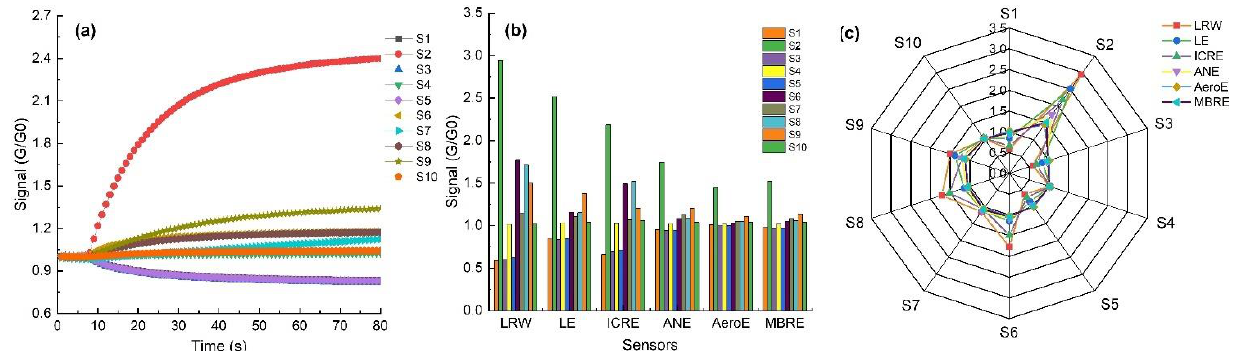
Figure 3. A typical response of EN sensor array during exposure to sample gas: ( a ) a typical response of EN during leachate detection, ( b ) the average values of EN signals at the 80th second, and ( c ) a radar fingerprint chart of EN signals.